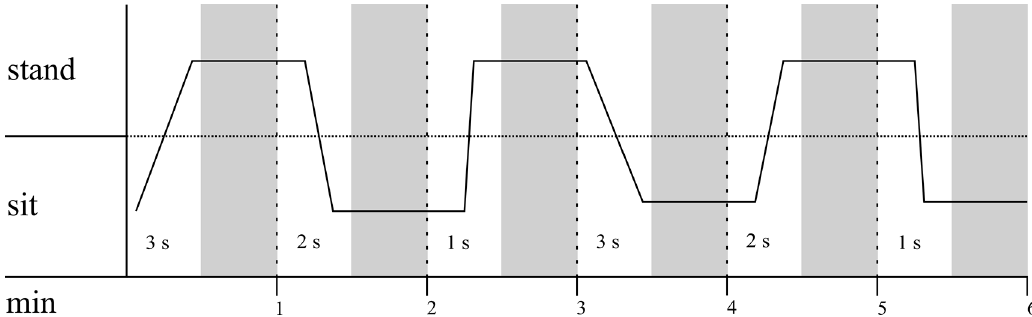
Figure 4. Laboratory part 3: Example of possible activity protocol of the first half of this laboratory part. Process is portrayed as a function of time. Thirty-second periods allocated for the participants’ posture changes in one of the three different speeds (1, 2, and 3 s) were excluded. The validity of sitting and standing after the participants had performed their transitions are depicted by the gray areas.